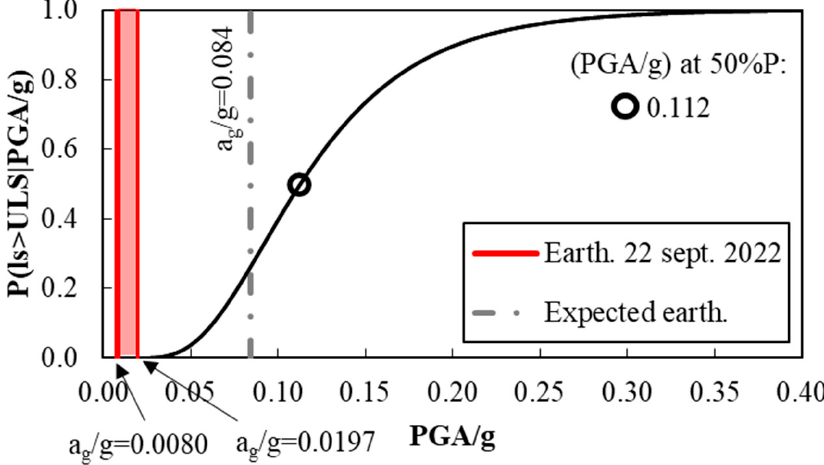
Figure 13. Urban fragility curves for Bargagli.